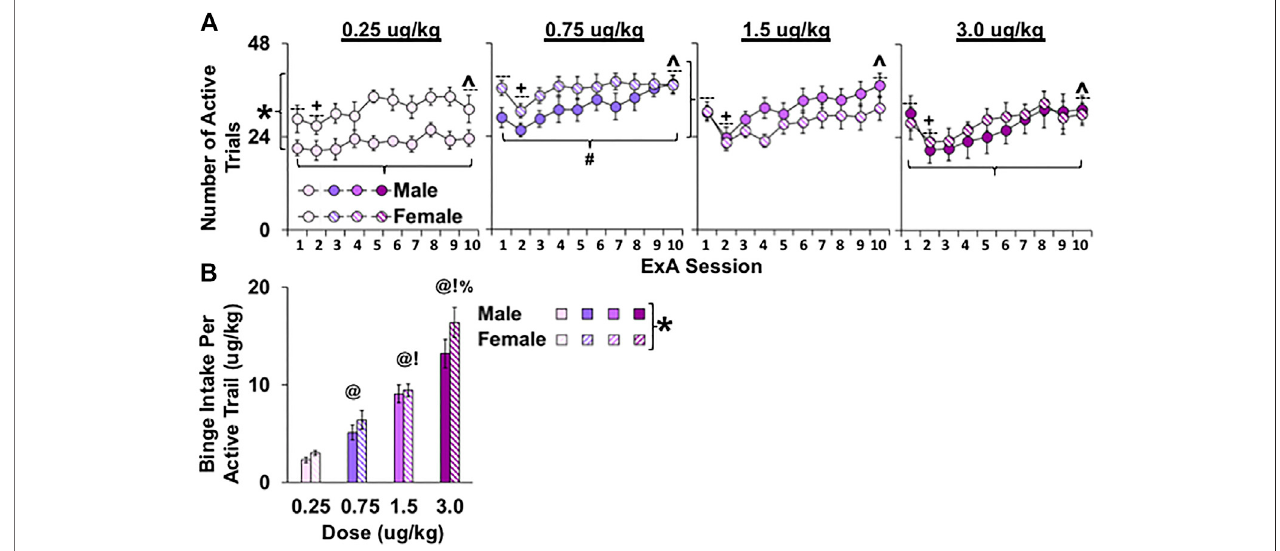
FIGURE2| Effectofsexanddoseonbingefentanylintakeinfemaleandmaleratsunderextended-accessconditions.Mean(±SEM)numberofactivetrialsforeach ofthe10extended-accesssessions (A) andbingefentanylintake( μ g/kg)inactivetrialsacrossallextended-accesssession (B) forfemalesandmaleswithinthe0.25( n = 8males, n =9females), 0.75( n =8males, n =9females), 1.5( n =8males, n =8females), and 3.0( n =8males, n =7females) dose ( μ g/kg)conditions.(*)Signi fi cantsex differencewithinthetwolowerdoses.(+)Signi fi cantdecreasefromsession1.( ^ )Signi fi cantincreasefromsession2.(#)Signi fi